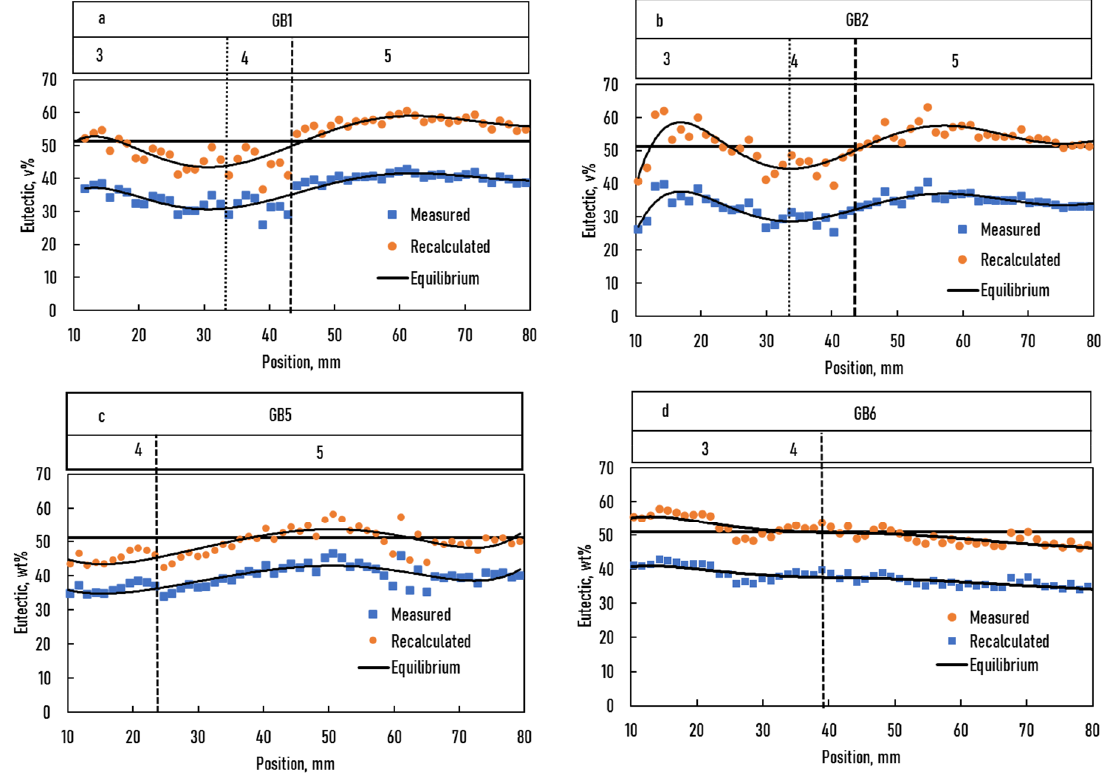
Figure 12. Measured, equilibrium, and recalculated amount of the eutectic vs. position in the sample: ( a ): GB1, ( b ): GB2, ( c ): GB5, ( d ): GB6.